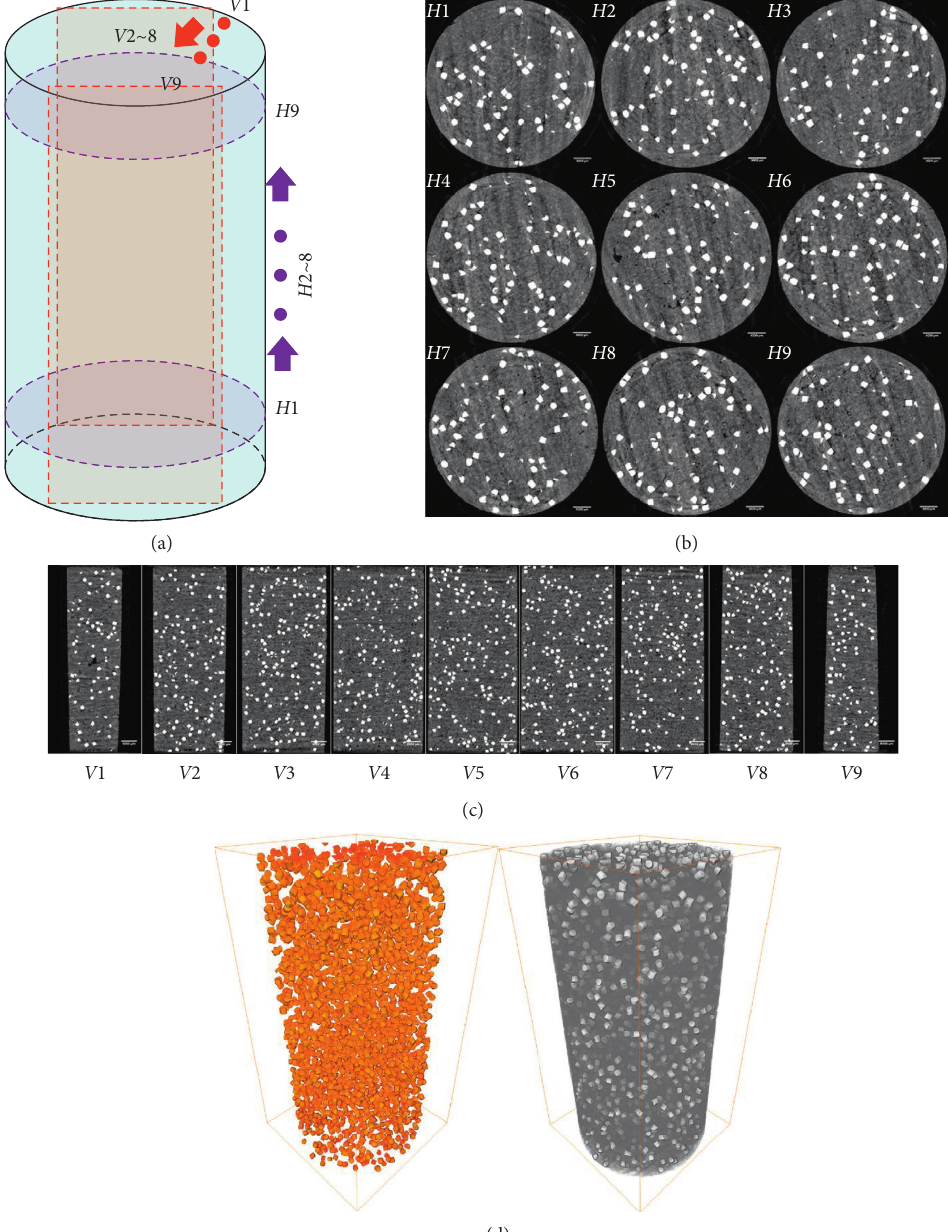
Figure 2: CT images for a specimen. (a) Schematic diagram for the extracted horizontal and vertical scanning slices, (b) horizontal scanning slices, (c) vertical scanning slices, and (d) three-dimensional